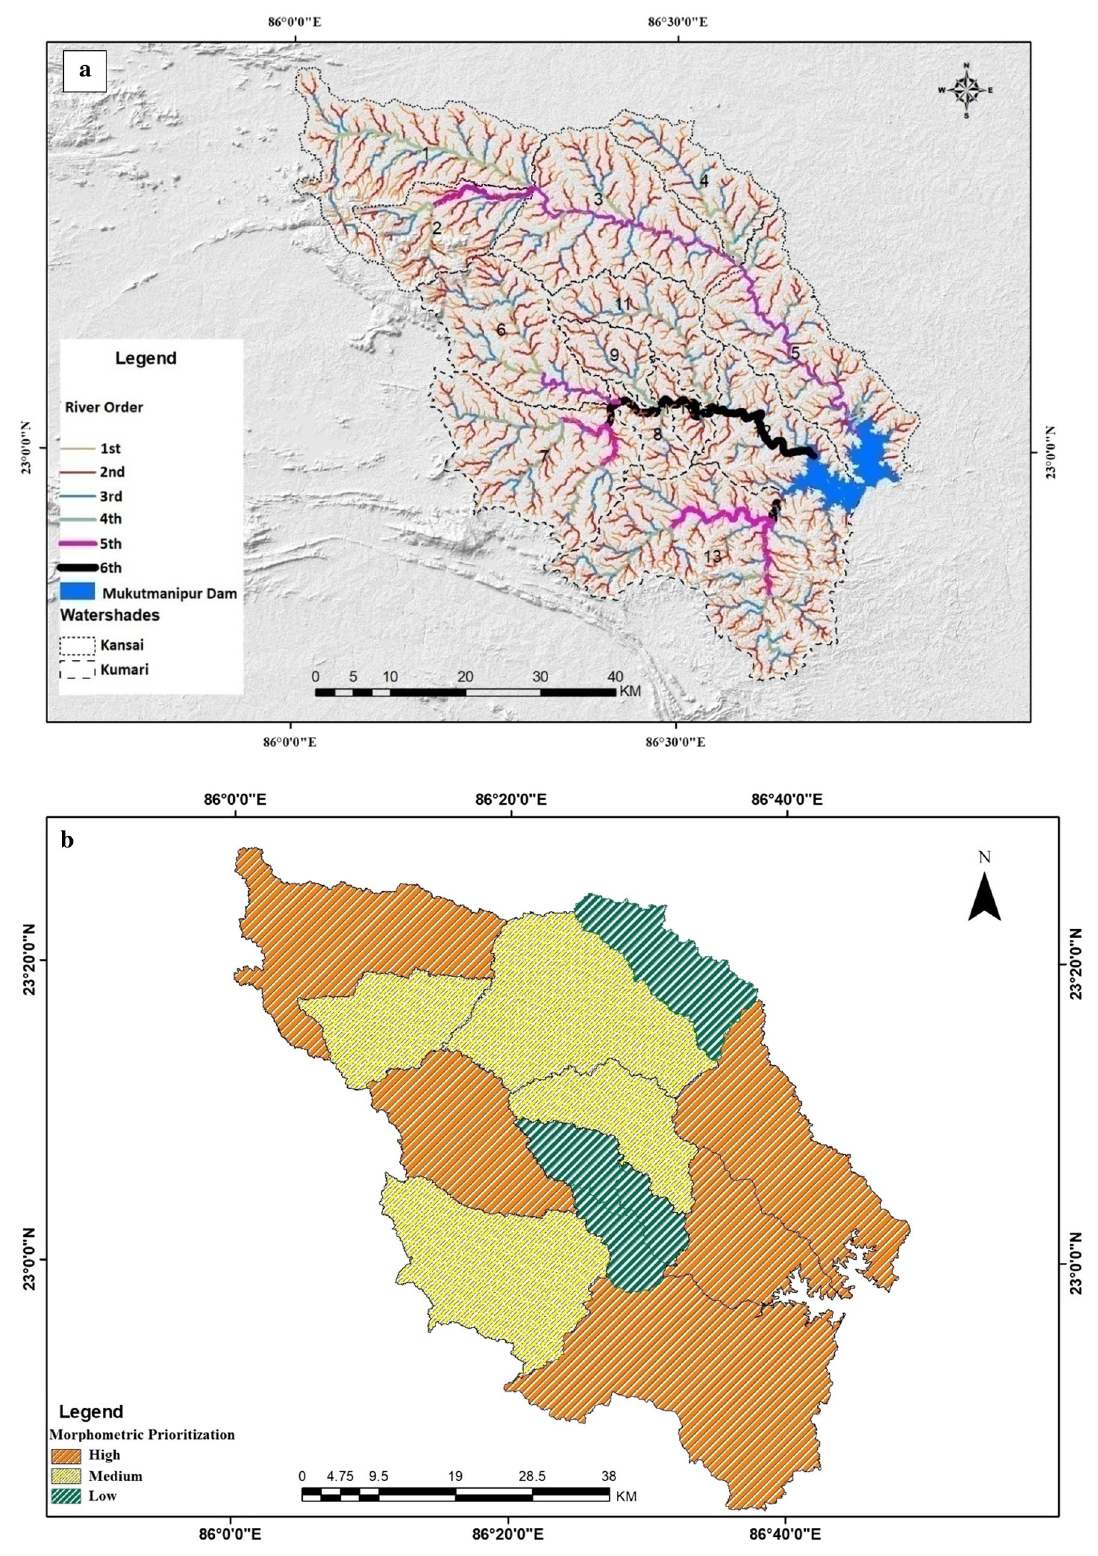
Fig. 3 a Drainage pattern and order and b priority based on morphometric parameters analysis in Kansai–Kumari reservoir catchment